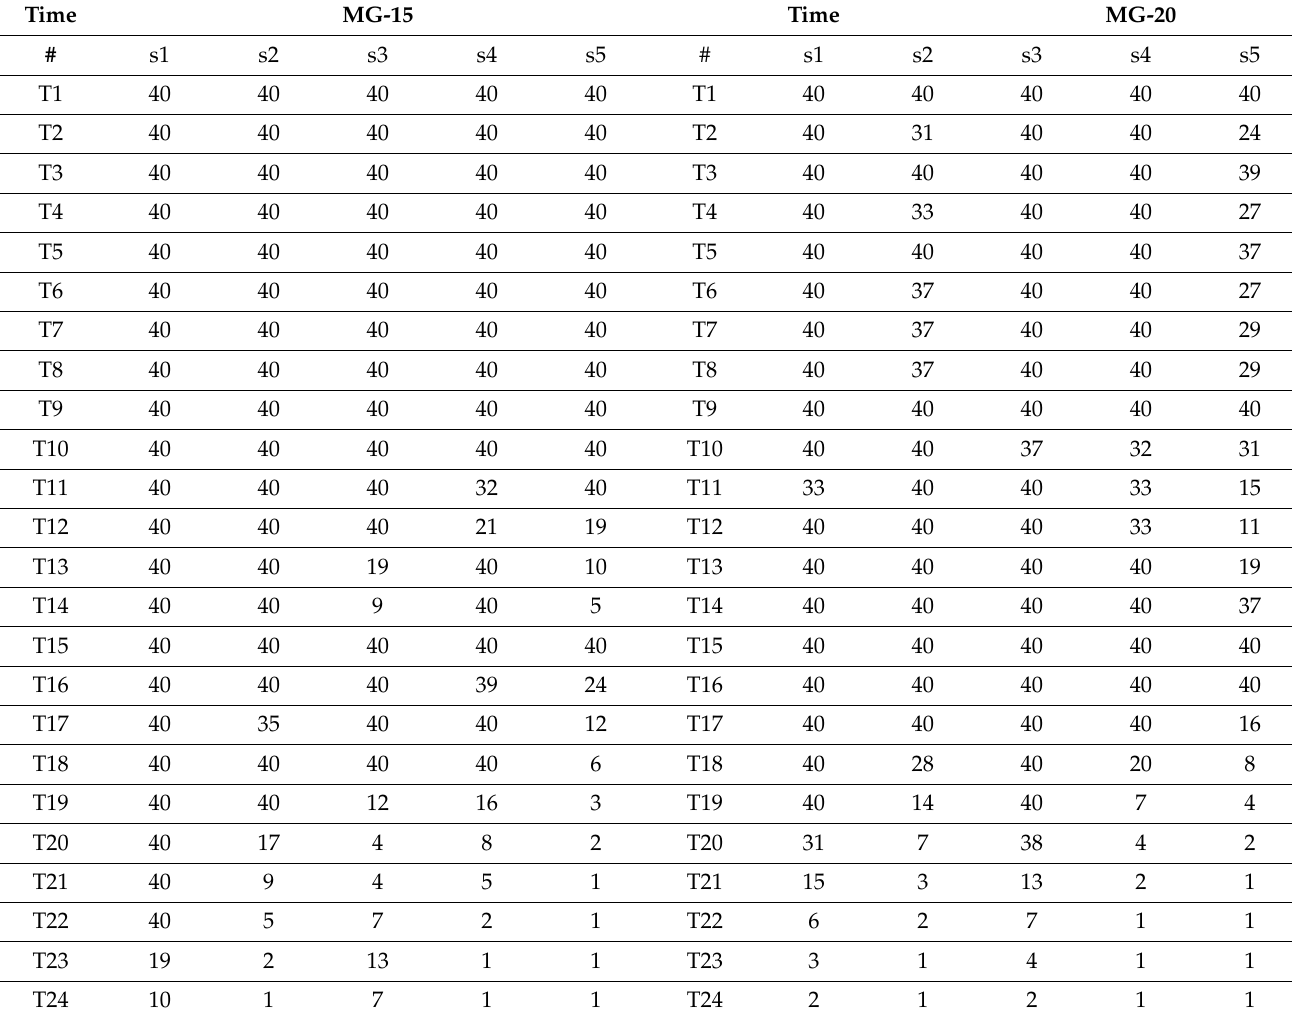
Table 7. The number of PEVs In Each